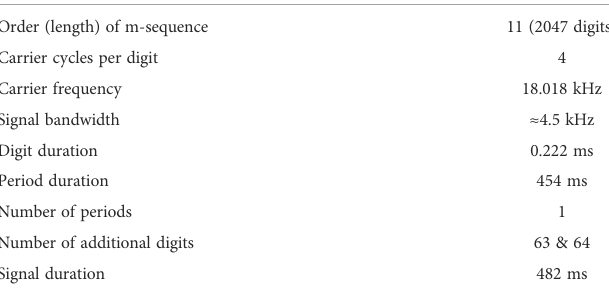
TABLE 1 Transmission signal